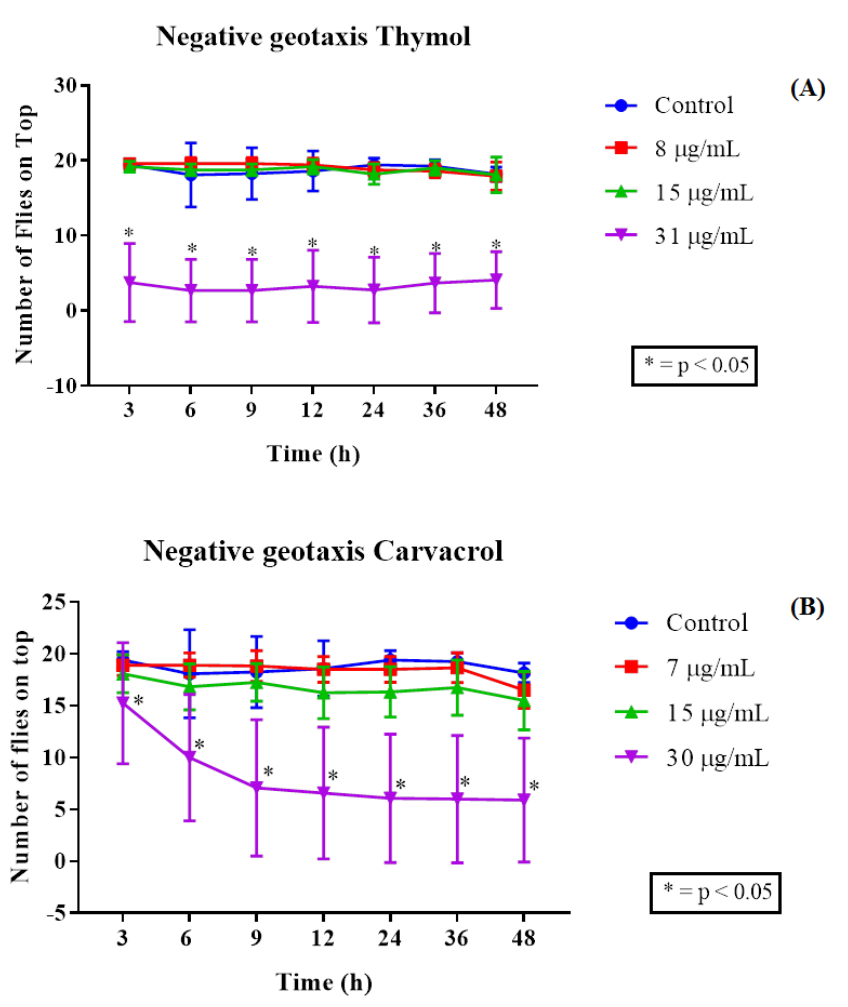
of D. melanogaster Figure 4. Toxic effect of varying thymol ( A ) and carvacrol ( B ) concentrations on the locomotor ability of D. melanogaster .